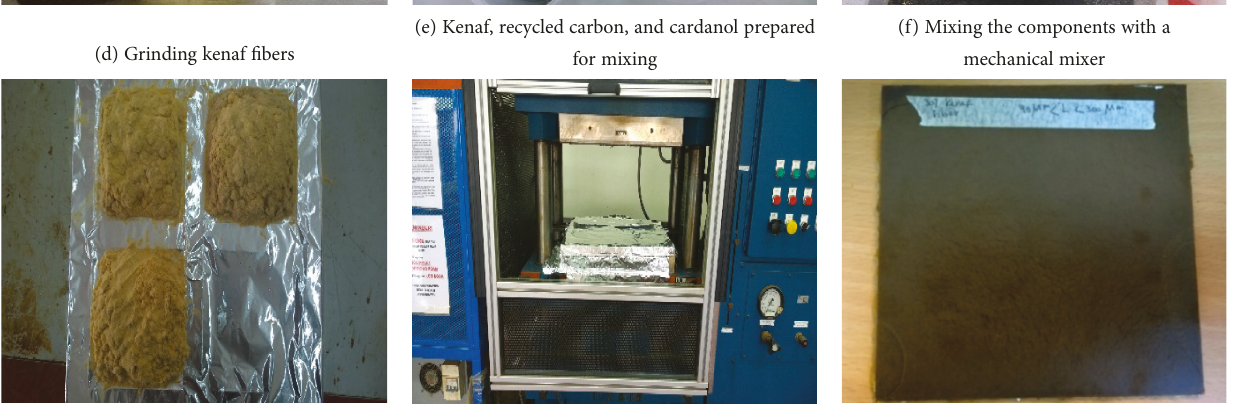
Figure 1: The procedure of the fabrication of the hybrid